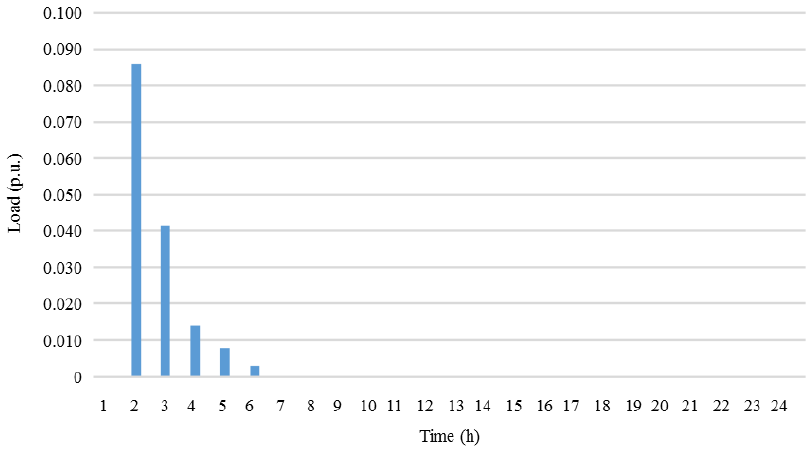
Figure 15. Load demand profile for Case 6 (30 EVs, controlled charging).